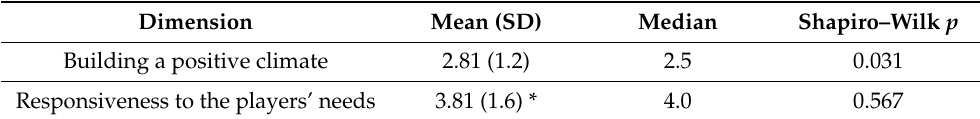
Table 7. Descriptive statistics and normality assessment for the ratings of quality of referee–players’ interactions in building a positive climate and responsiveness